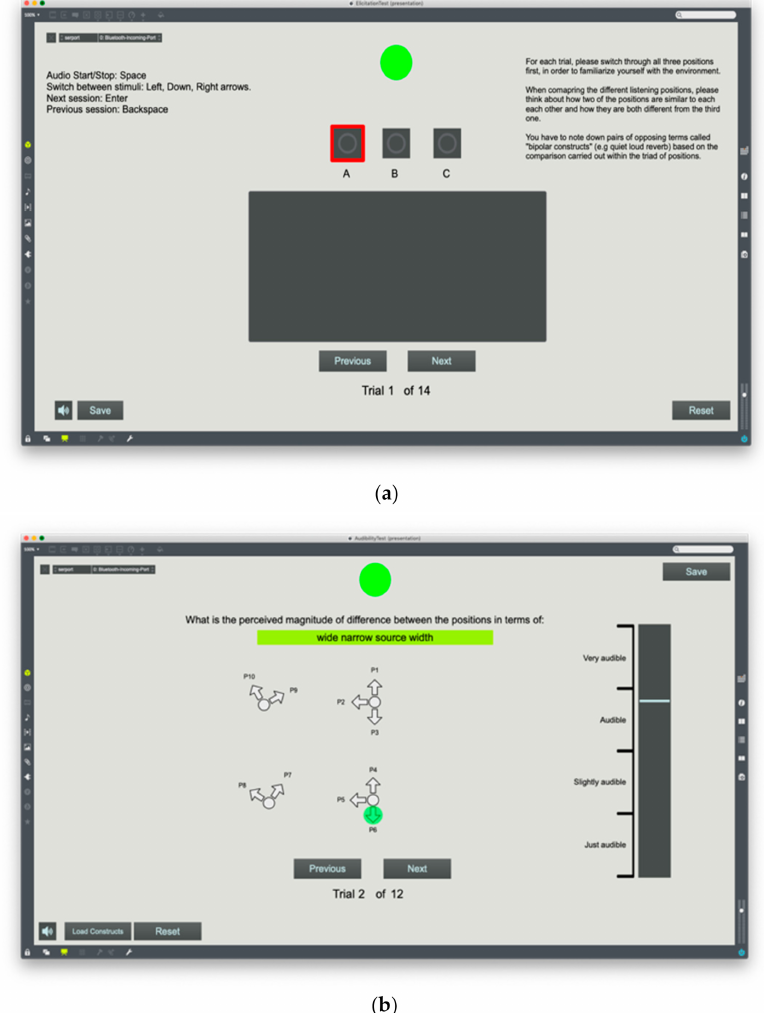
Figure 3. Graphical user interfaces used for the lab experiments. ( a ) Elicitation test ( b ) Audibility